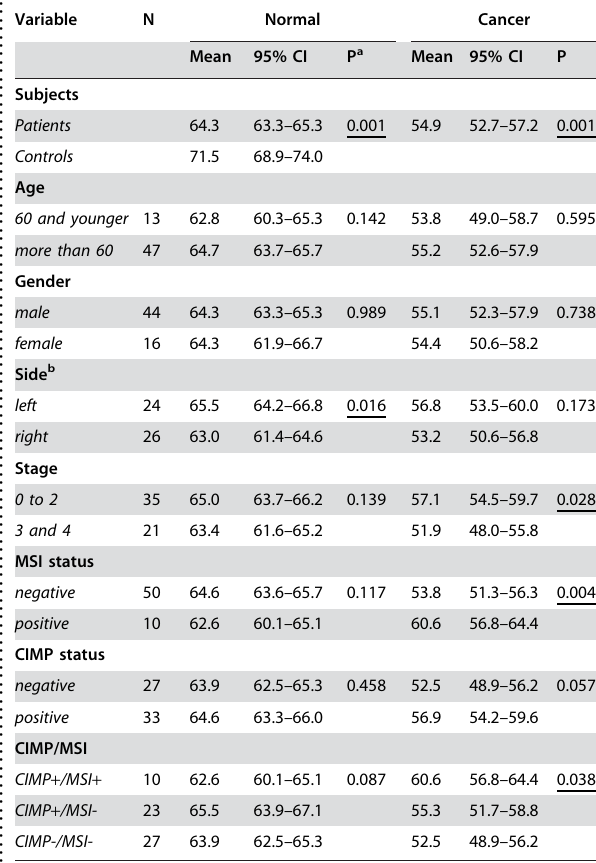
Table 1. Methylation density of LINE-1and clinical and demographic characteristics of 60 colorectal carcinomas